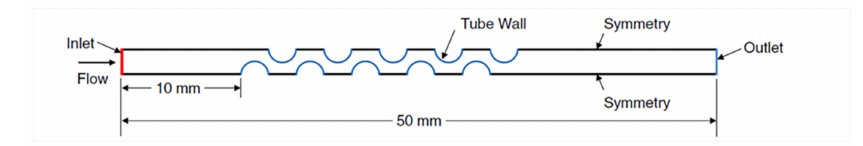
Figure 9. Schematic diagram of the computational